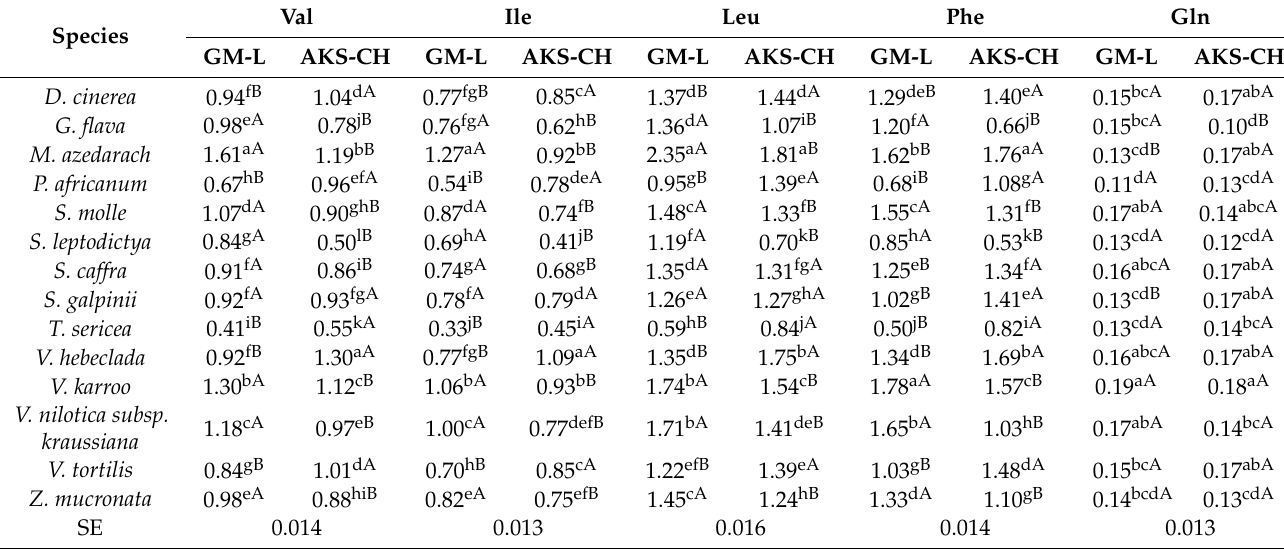
Table 7. Effect of species and soil type on Val, Ile, Leu, Phe and Gln (g/100 g sample) of browse species found in GM-L AKS-CH soil